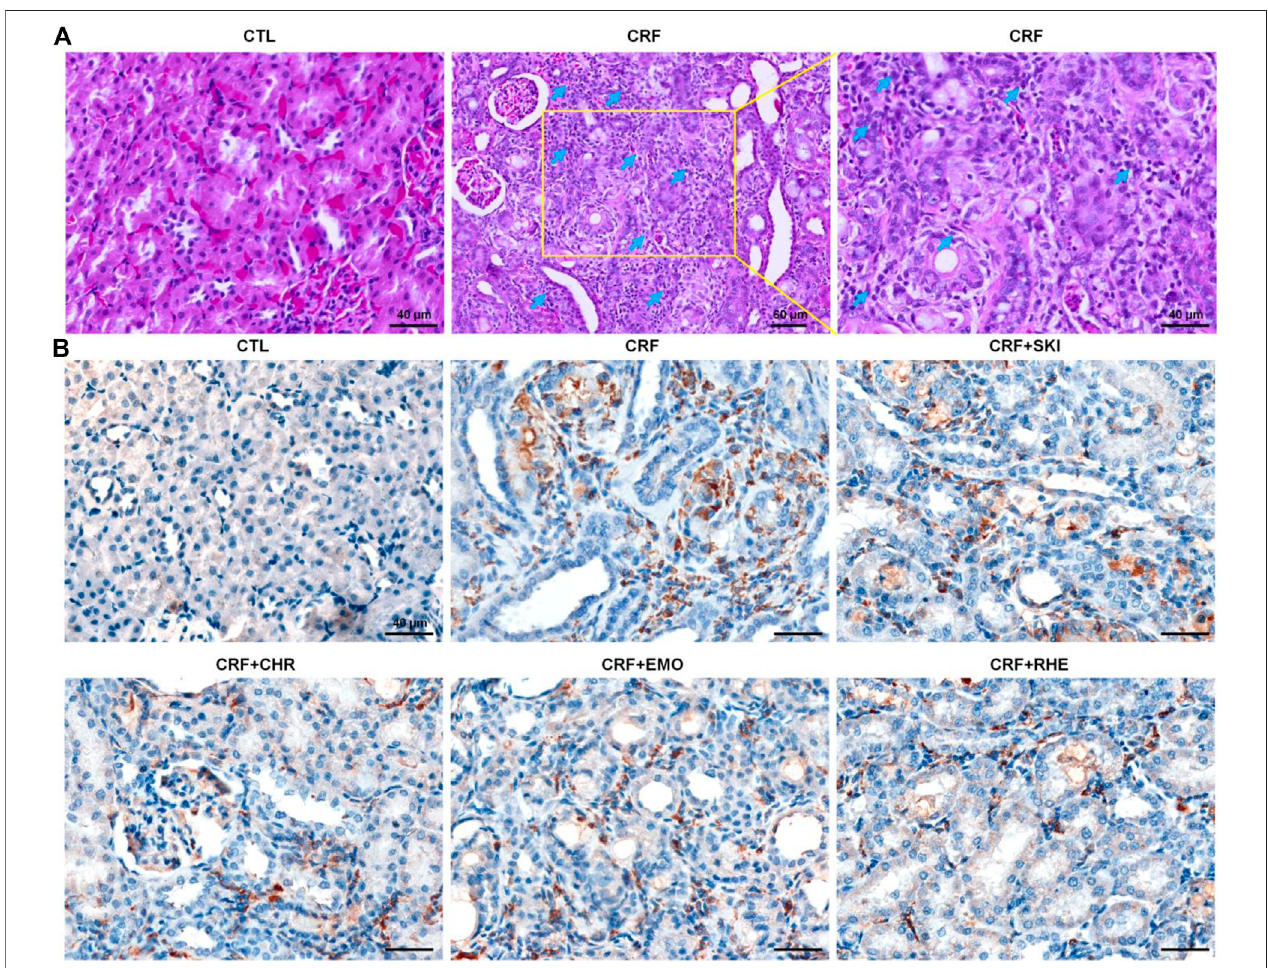
FIGURE 3 | SKI and three anthraquinones including chrysophanol, emodin, and rhein inhibited in fl ammation in the adenine-induced CRF rats. (A) Images of H&E stainingofthekidneytissues inthedifferentgroupsScalebar,40and60 μ m.Numerousin fl ammatorycellswereindicatedbyarrows. (B) Immunohistochemicalanalysis with anti-CD68 of the kidney tissues in the different groups. Scale bar, 40 μ